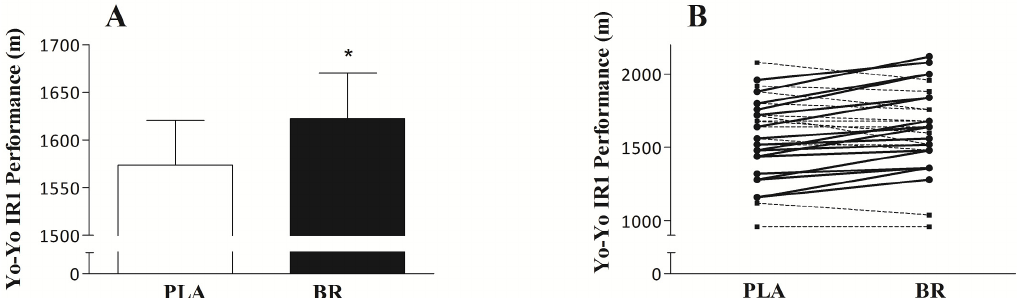
Figure 2. Mean distance covered during the Yo ‐ Yo IR 1 test ( A ), and the individual response ( B )